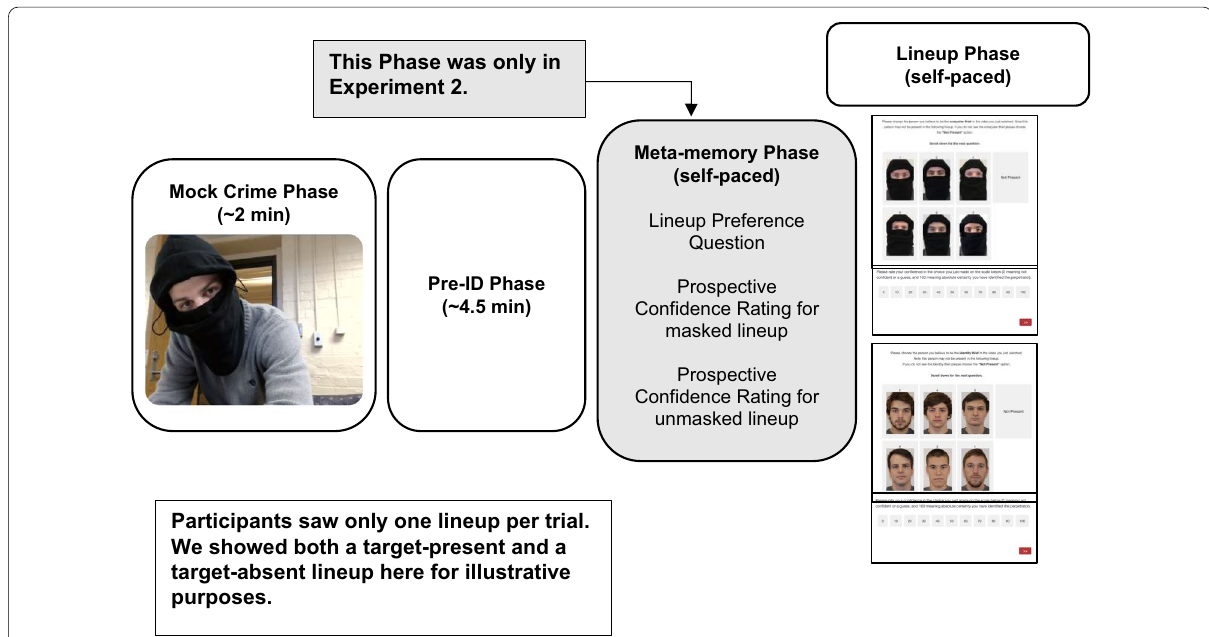
Fig. 1 Depiction of a single trial. Each participant completed four trials, one for each of the four conditions